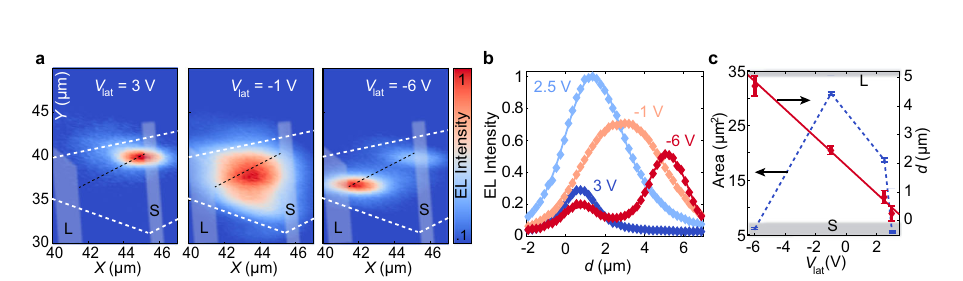
Fig. 3 | Electrical control of the spatial emission pro fi le. a Spatial EL emission pattern integrated over the whole spectral range at different lateral voltages V lat . The source (S) and lateral (L) contacts are highlighted in gray. White dashed lines indicate the WSe 2 edges. b Normalized EL intensity as a function of the distance